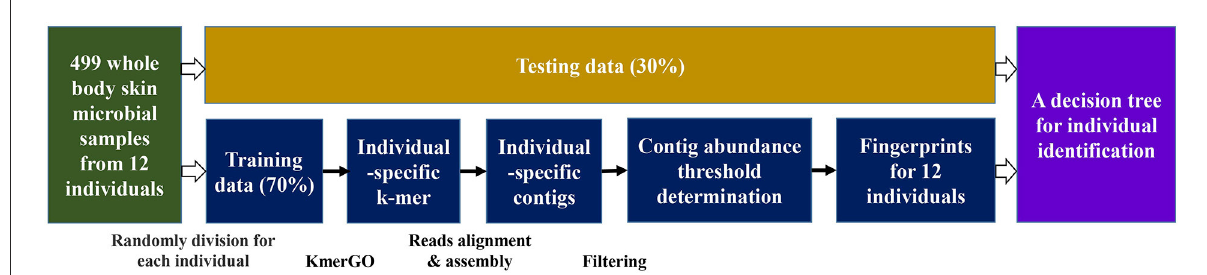
FIGURE3 The flow chart shows the framework of our whole experiment. After data preprocessing, the samples of each individual are divided into the training set and the test set according to the 7:3 ratio. After a series of operations on the training data, we obtained fingerprints for 12 individuals and examined the testing data by a decision tree.